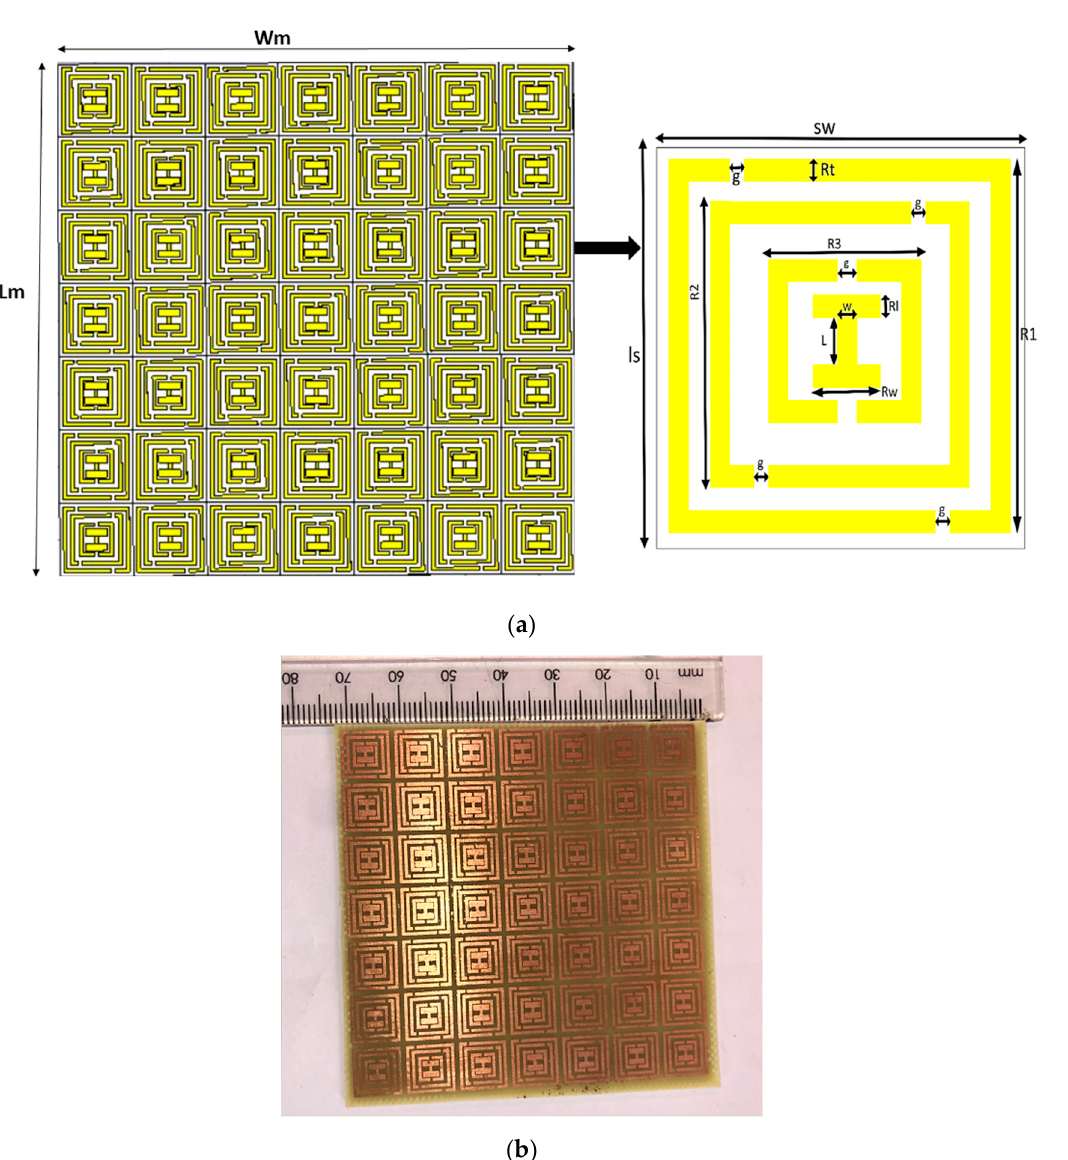
4 of 19 Table 1. Dimensional parameters of the 7 × 7 array. Parameter